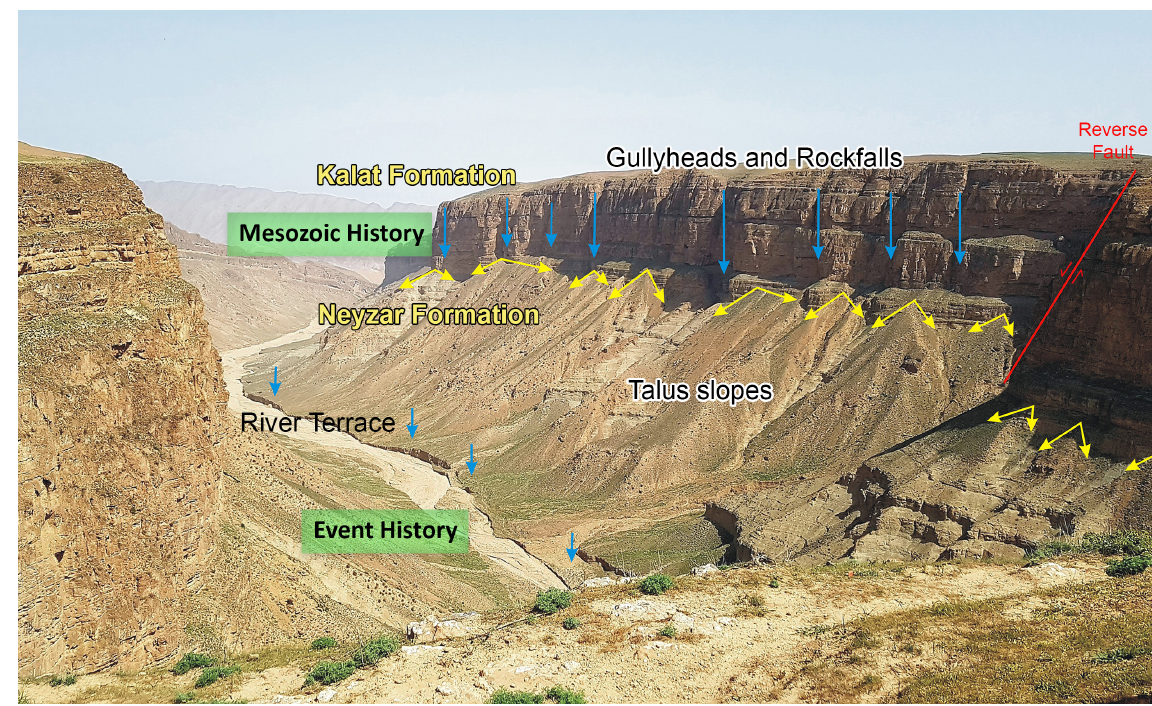
Figure 10 . Geodiversity and Dynamic Equilibrium at the Landform Scale, Kalat-e Naderi Canyon (Photo by author 1401)